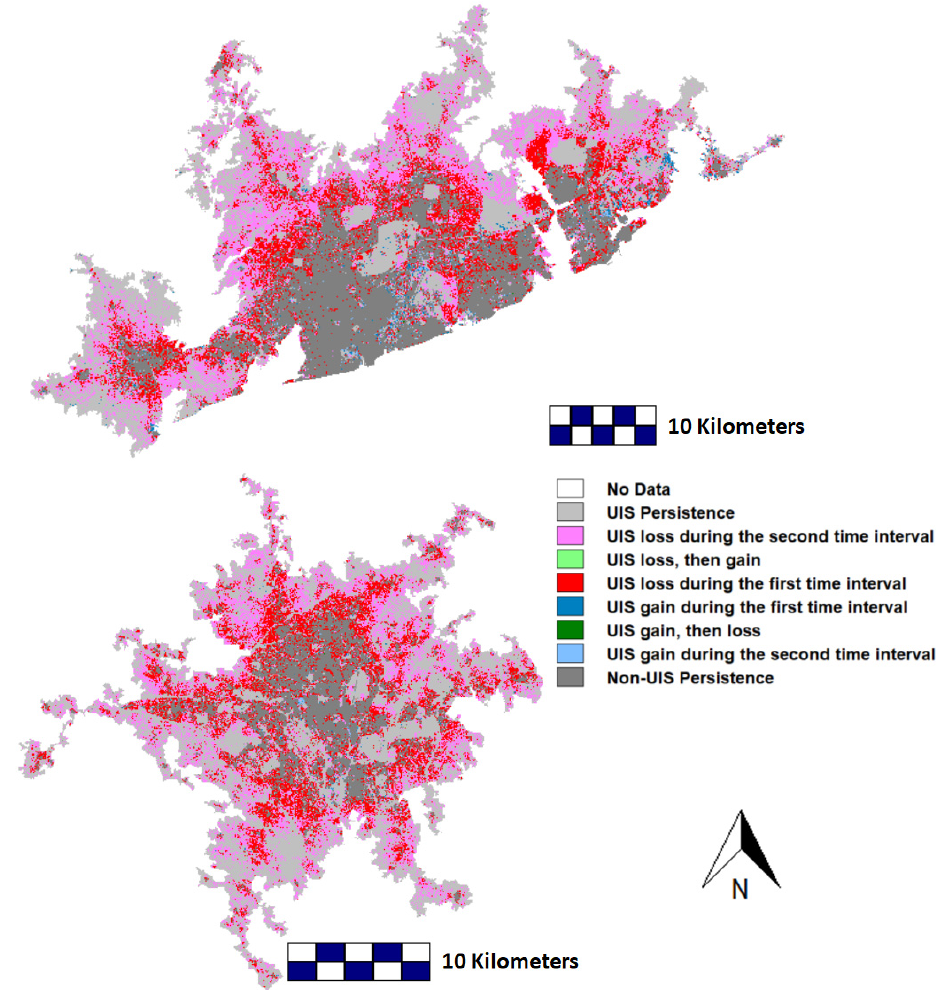
Figure 4. Three-way map overlay for Accra ( top ) and Kumasi ( bottom ). The two shades of gray show no change, while the other colors apart from white in the legend show change involving UIS. Table 3. Sizes of trajectories that constitute the uni fi ed region in Accra.